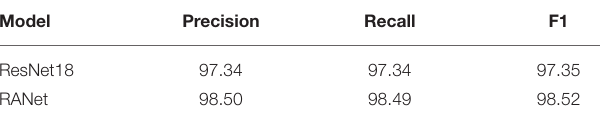
TABLE 5 | Model performance evaluation.